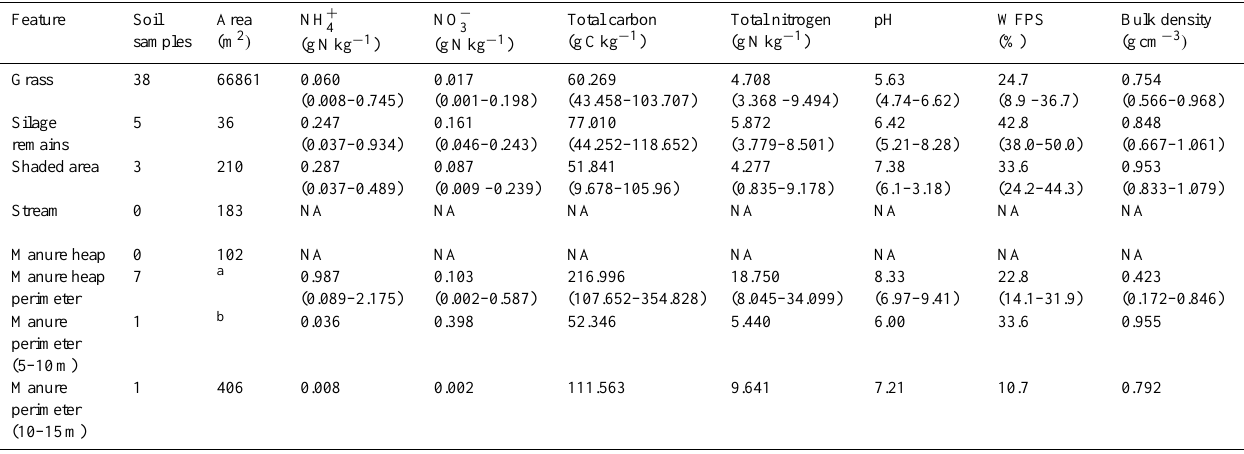
Table 1. Summary of relevant soil properties of all 55 soil measurements made during flux measurements. Soil samples were taken from inside the chamber area immediately after flux measurements were completed. The mean values and range (in brackets) of measurements from each variable within the field are included in the